Question: Condense the content of this figure into a single sentence.
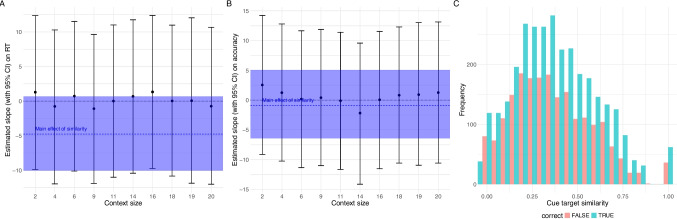
Answer: Effect of cue-target similarity in Experiment 3. A The slopes of the similarity on RTs of the mixed effects regression for the different context sizes. The main effect of similarity and the 95% CI is plotted in blue. B The slopes of the similarity on accuracy of the mixed effects regression for the different context sizes. The main effect of similarity and the 95% CI is plotted in blue. C A histogram of the cue-target similarities of Experiment 3 for all word pairs from the conditions where we manipulated the context size. Shown are only the values for the condition with a context size. All error bars represent the 95% CIs